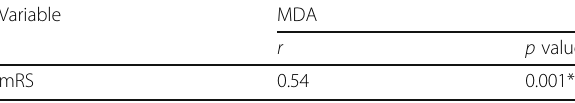
Table 4 Correlation between mRS and malondialdehyde